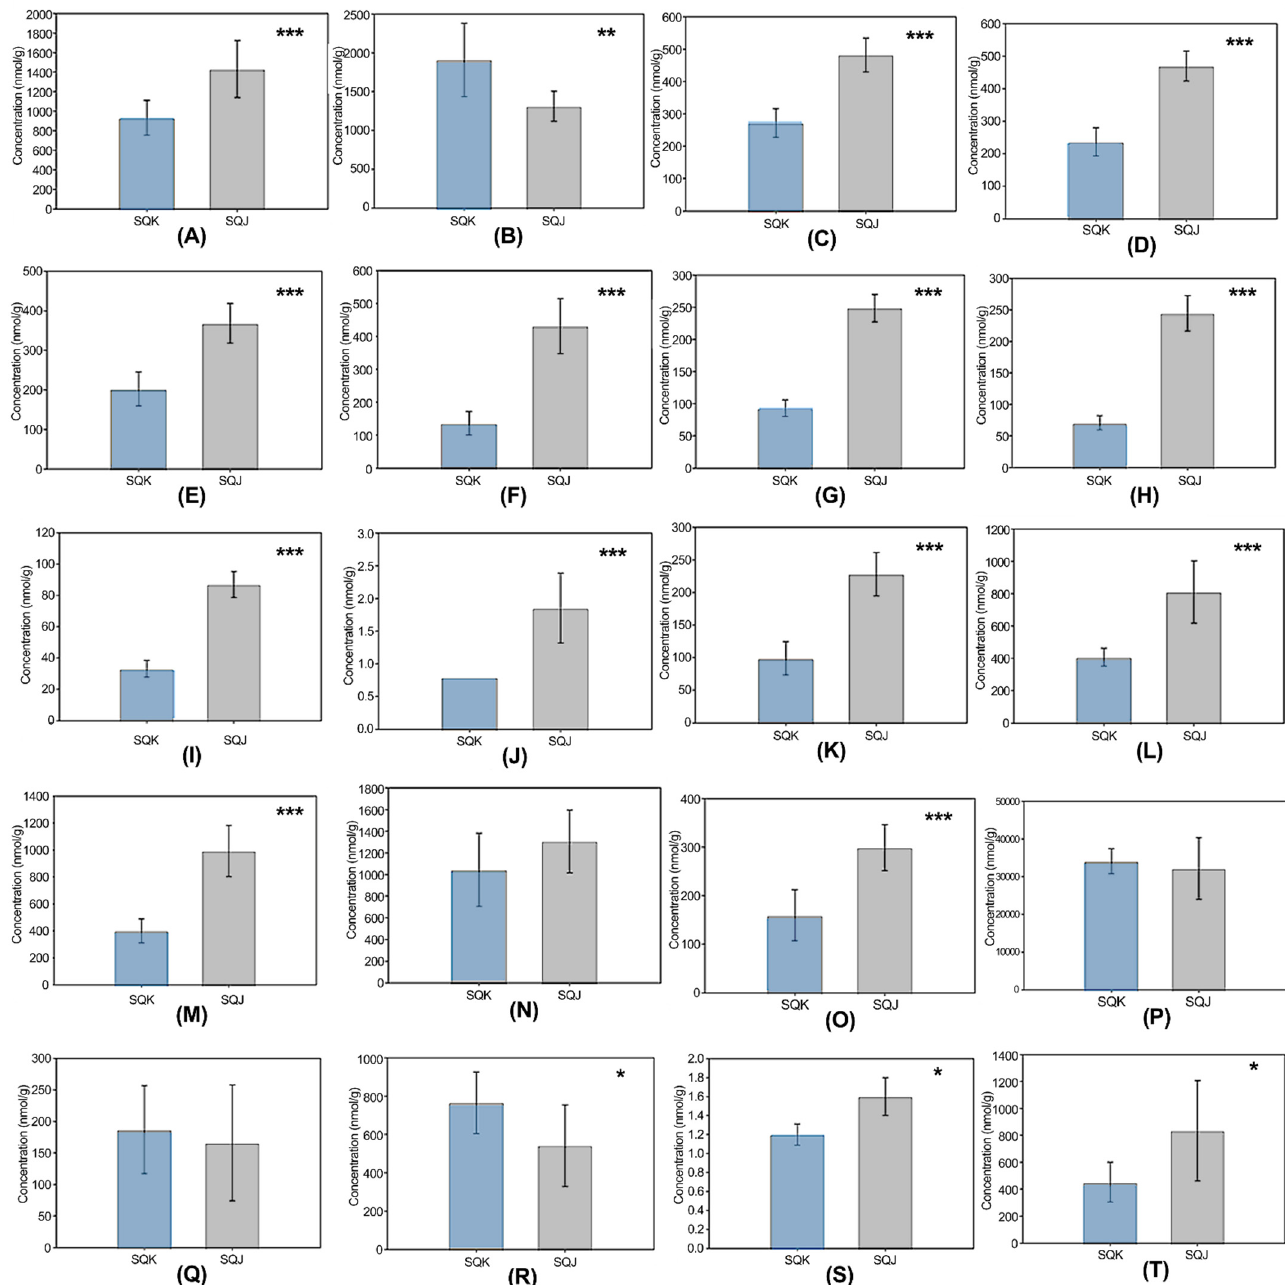
Figure 4. Differences observed in metabolite analysis of 20 amino acids between SQK ( n = 10, blue bars) and SQJ ( n = 10, gray bars): ( A ) glycine, ( B ) alanine, ( C ) valine, ( D ) leucine, ( E ) isoleucine, ( F ) proline, ( G ) phenylalanine, ( H ) tyrosine, ( I ) tryptophan, ( J ) cysteine, ( K ) methionine, ( L ) serine, ( M ) threonine, ( N ) lysine, ( O ) arginine, ( P ) histidine, ( Q ) aspartate, ( R ) glutamate, ( S ) asparagine, and ( T ) glutamine. Error bars represent standard deviation. Significant differences were calculated using Welch’s test (* < 0.05, ** < 0.01, and *** < 0.001).